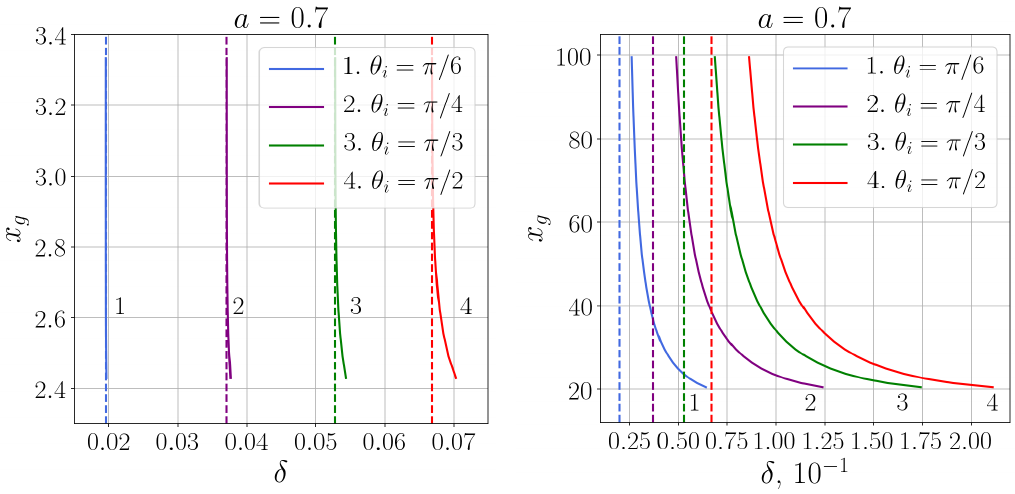
Figure 7. The case of the spin a = 0.7. Left : Relation between x g and δ for the black hole with the polarization profile (56). Right : Relation between x g and δ for the black hole with the regularized Newtonian profile